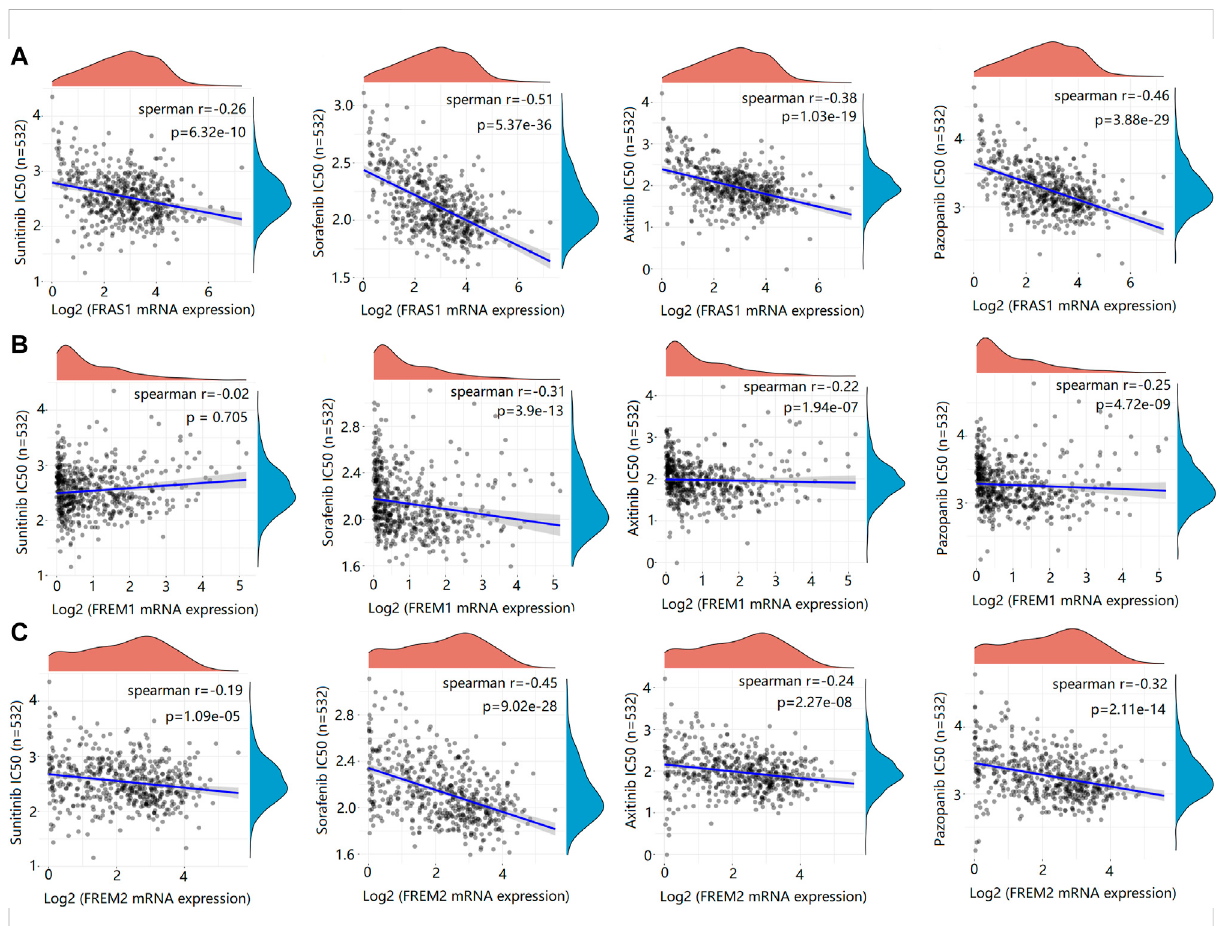
FIGURE 11 Drug sensitivity analysis of IC50 score and FRAS1/FREM expression. (A) Spearman correlation analysis of IC50 score and FRAS1 expression including four common targeted therapeutic drugs (sunitinib, sorafenib, axitinib and pazopanib) in KIRC. (B) Spearman correlation analysis of IC50 score and FREM1 expression. (C) Spearman correlation analysis of IC50 score and FREM2